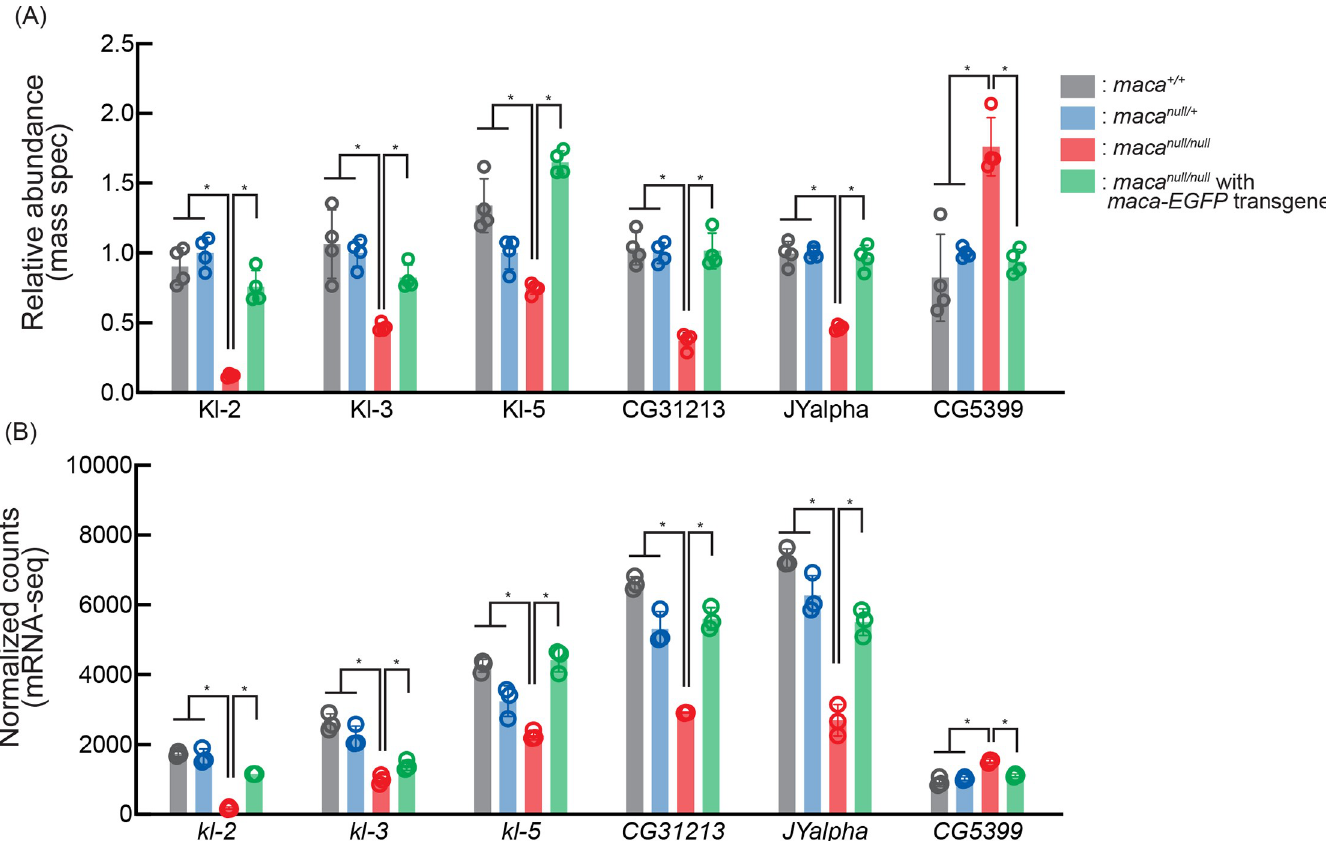
Fig 5. Abundance of both protein and mRNA of kl-2 , kl-3 , and kl-5 are decreased in maca null/null testes. (A) Relative abundance of dysregulated proteins determined by mass spec whose mRNAs were also dysregulated in maca null/null compared with all the other tested genotypes. Mean +/- SD (n = 4 biological replicates). Adjusted P- values < 0.05 are indicated by � . (B) Normalized counts (reflecting relative abundance) of dysregulated mRNAs determined by poly-A+ RNA-seq whose protein products were also dysregulated in maca null/null compared with all the other tested genotypes. Mean +/- SD (n = 3 biological replicates). Adjusted P-values < 0.01 are indicated by �